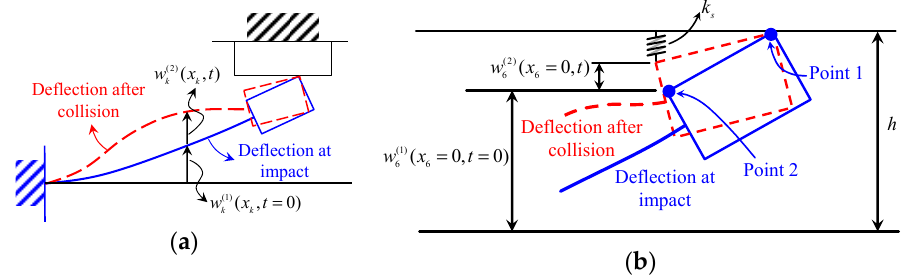
Figure 3. ( a ) Schematic of the beam deflection after impact; ( b ) The spring model of the contact.